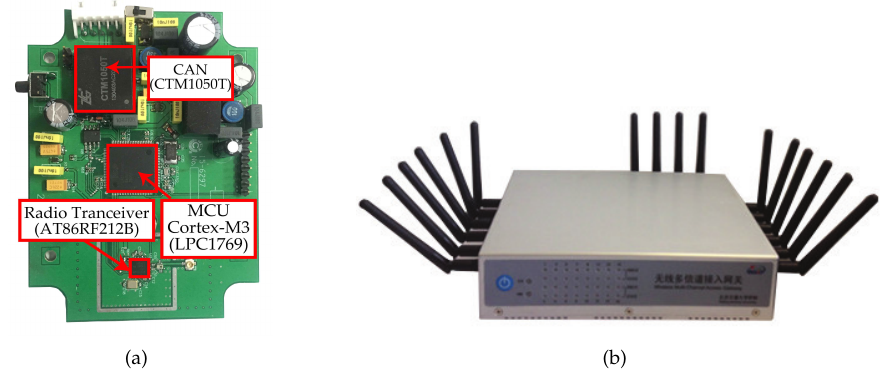
Figure 9. Hardware of WirelessCAN node and Gateway. ( a ) A node; ( b ) A Gateway.